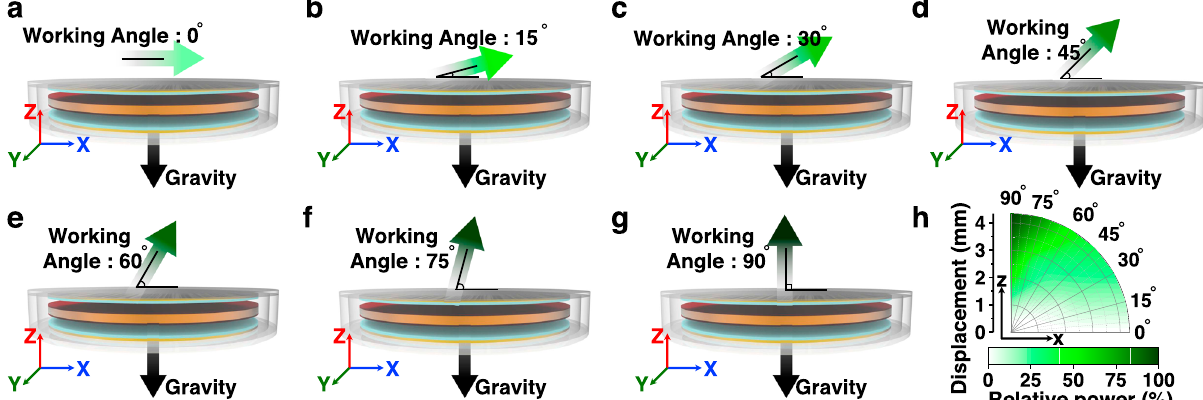
Fig. 3 I-TENG power performance according to displacement and working angle. a – g Demonstration that the I-TENG ’ s displacement direction depends on the working angle. h The output voltage distribution of the I-TENG according to displacement and working angle of